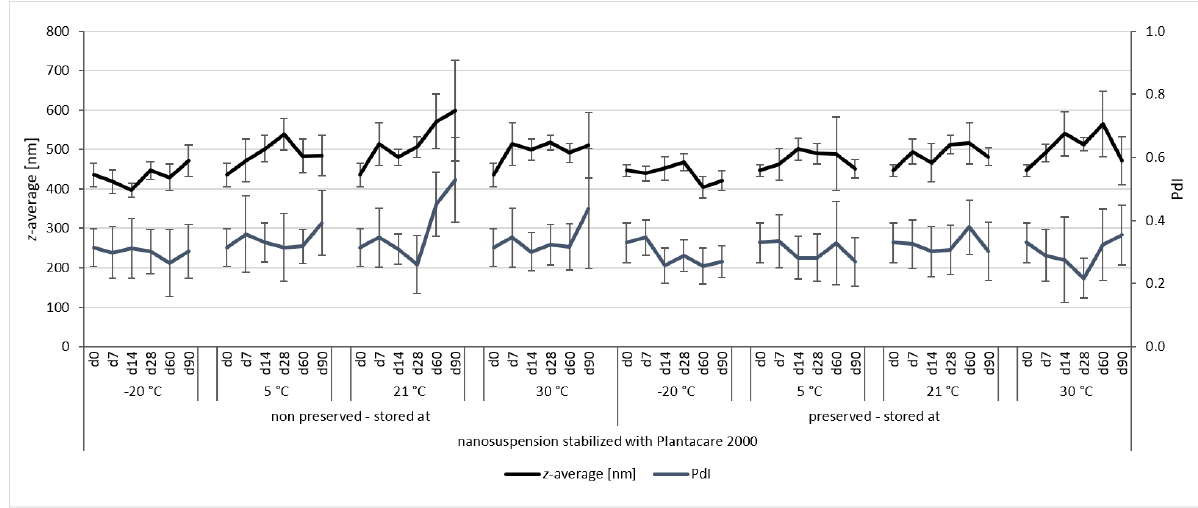
Figure 7: Physical stability during three months of storage at different storage temperatures for the nanosuspensions stabilized with Plantacare 2000 (DLS data).